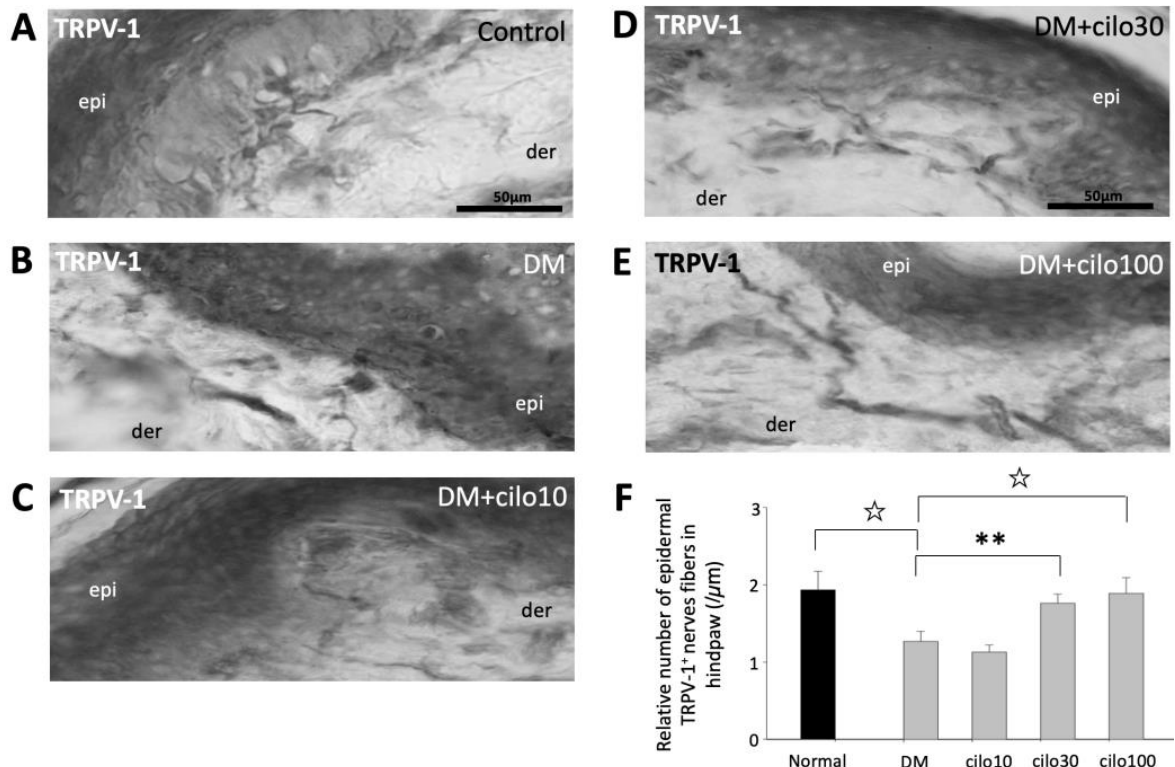
Figure 5. Ameliorated levels of TRPV-1 – positive epidermal nerve endings in hind paws of diabetic rats treated with cilostazol (cilo). TRPV-1 immuno-labeled sensory nerve fibers are indicated by white arrowheads in cryo-sectioned hind paws samples from ( A ) control rats, ( B ) DM rats, and DM rats receiving ( C ) 10 mg/kg (Cilo10), ( D ) 30 mg/kg (Cilo30), and ( E ) 100 mg/kg (Cilo100) daily dosage of cilostazol. The relative density of intraepidermal TRPV-1-positive nerve fibers ( F ) in the epidermal layers of hind paws is shown. Cilo10, 10 mg/kg cilostazol; Cilo30, 30 mg/kg cilostazol; Cilo100, 100 mg/kg cilostazol. Bars represent the average number of detectable labelled fibers in 5 mm skin sections. ** Indicates p < 0.01, and ☆ at p < 0.001, Mann – Whitney U test. Error bars represent SE. 3.4. Cilostazol Reduced Aberrant Expression of Glia Cells in the Spinal Dorsal Horn of Diabetic